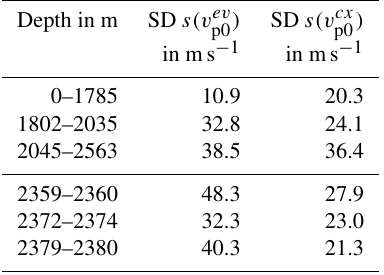
Table 1. Standard deviation of mean interval P-wave velocities at vertical incidence for several depth intervals of the EDML ice